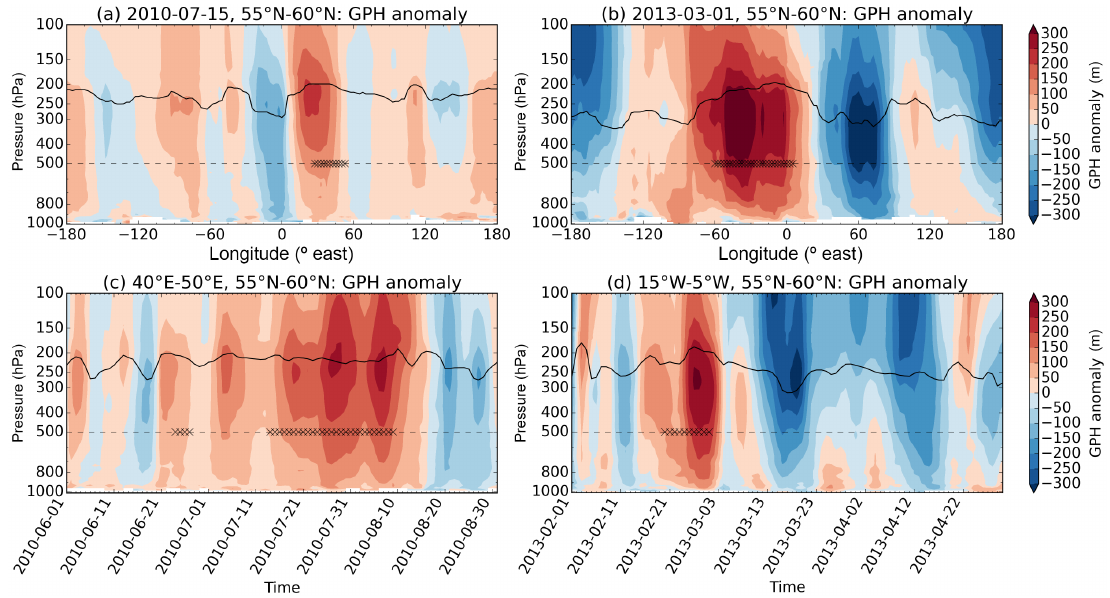
Figure 6. GPH anomalies during (left column) Russian blocking and (right column) Greenland blocking. Panels (a, b) : meridional cross sections of GPH for 2 exemplary days and regions as well as (c, d) temporal evolution of GPH for the same regions. Blocking (crosses) at the 500hPa level (dashed line) is indicated if at least one grid cell in the averaged area is blocked. The solid line denotes the lapse-rate